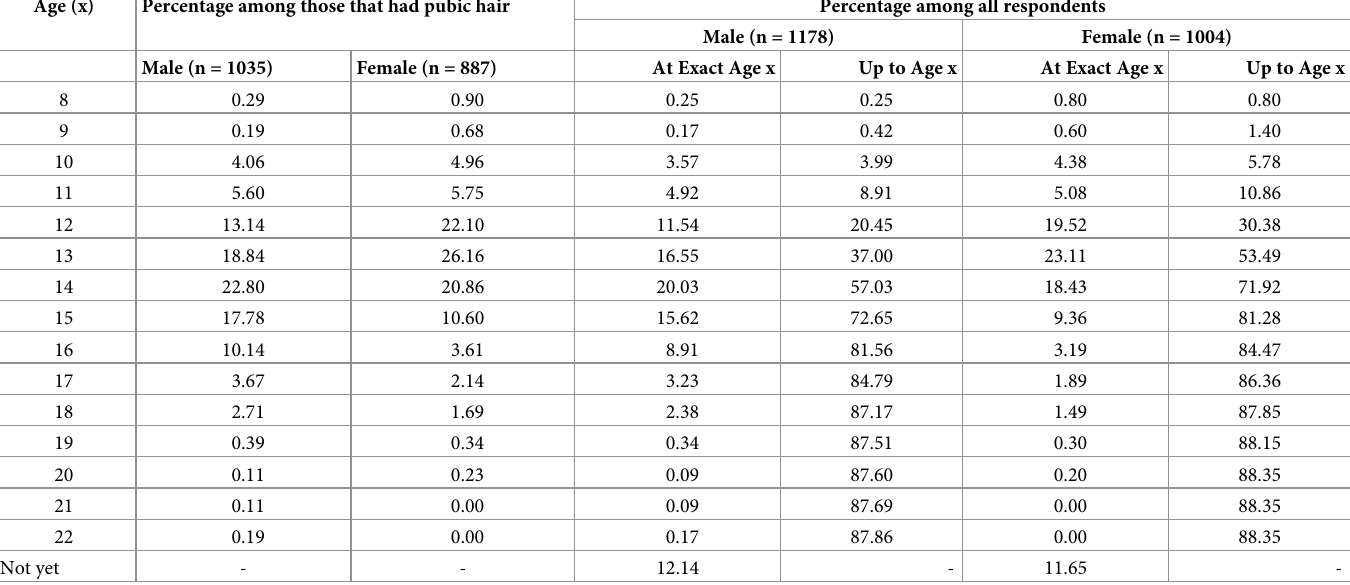
Table 3. Percentage distribution of developing pubic hair at a given age among those that had already started and among all respondents. Age (x) Percentage among those that had pubic